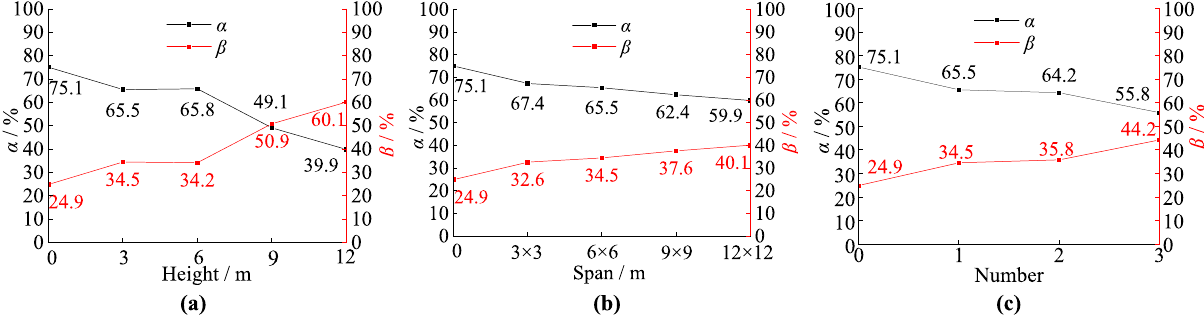
Figure 9. The shaft resistances’ ratios and tip resistances’ ratios: ( a ) cave’s height; ( b ) cave’s span; ( c ) cave’s Analysis of tip resistance and shaft resistance under ultimate bearing capacity of piles. The